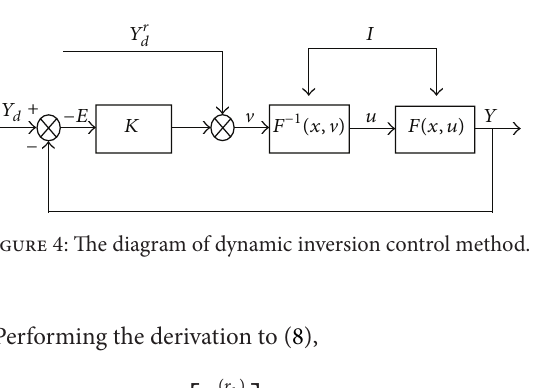
Figure 3: The structure of the single hidden neural network.